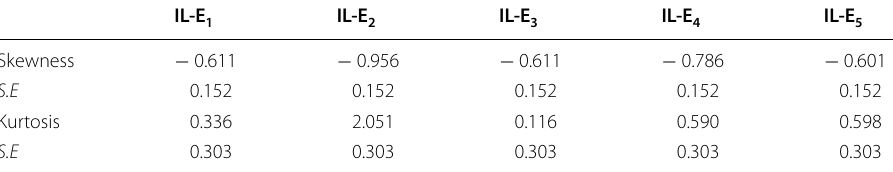
S.E. standard error